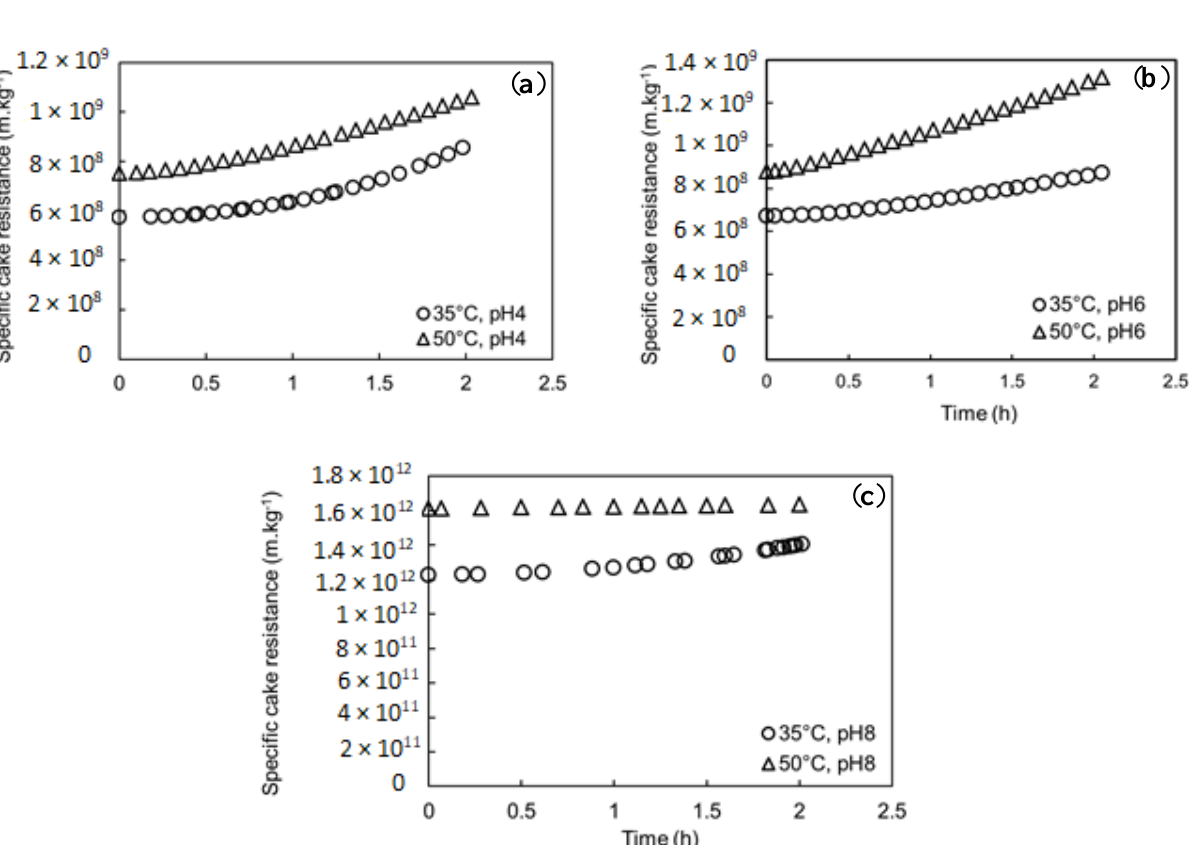
Figure 5. Simulations of Specific cake resistance with time at different feed temperatures and pH, ( a ) pH 4, ( b ) pH 6, and ( c ) pH 8.